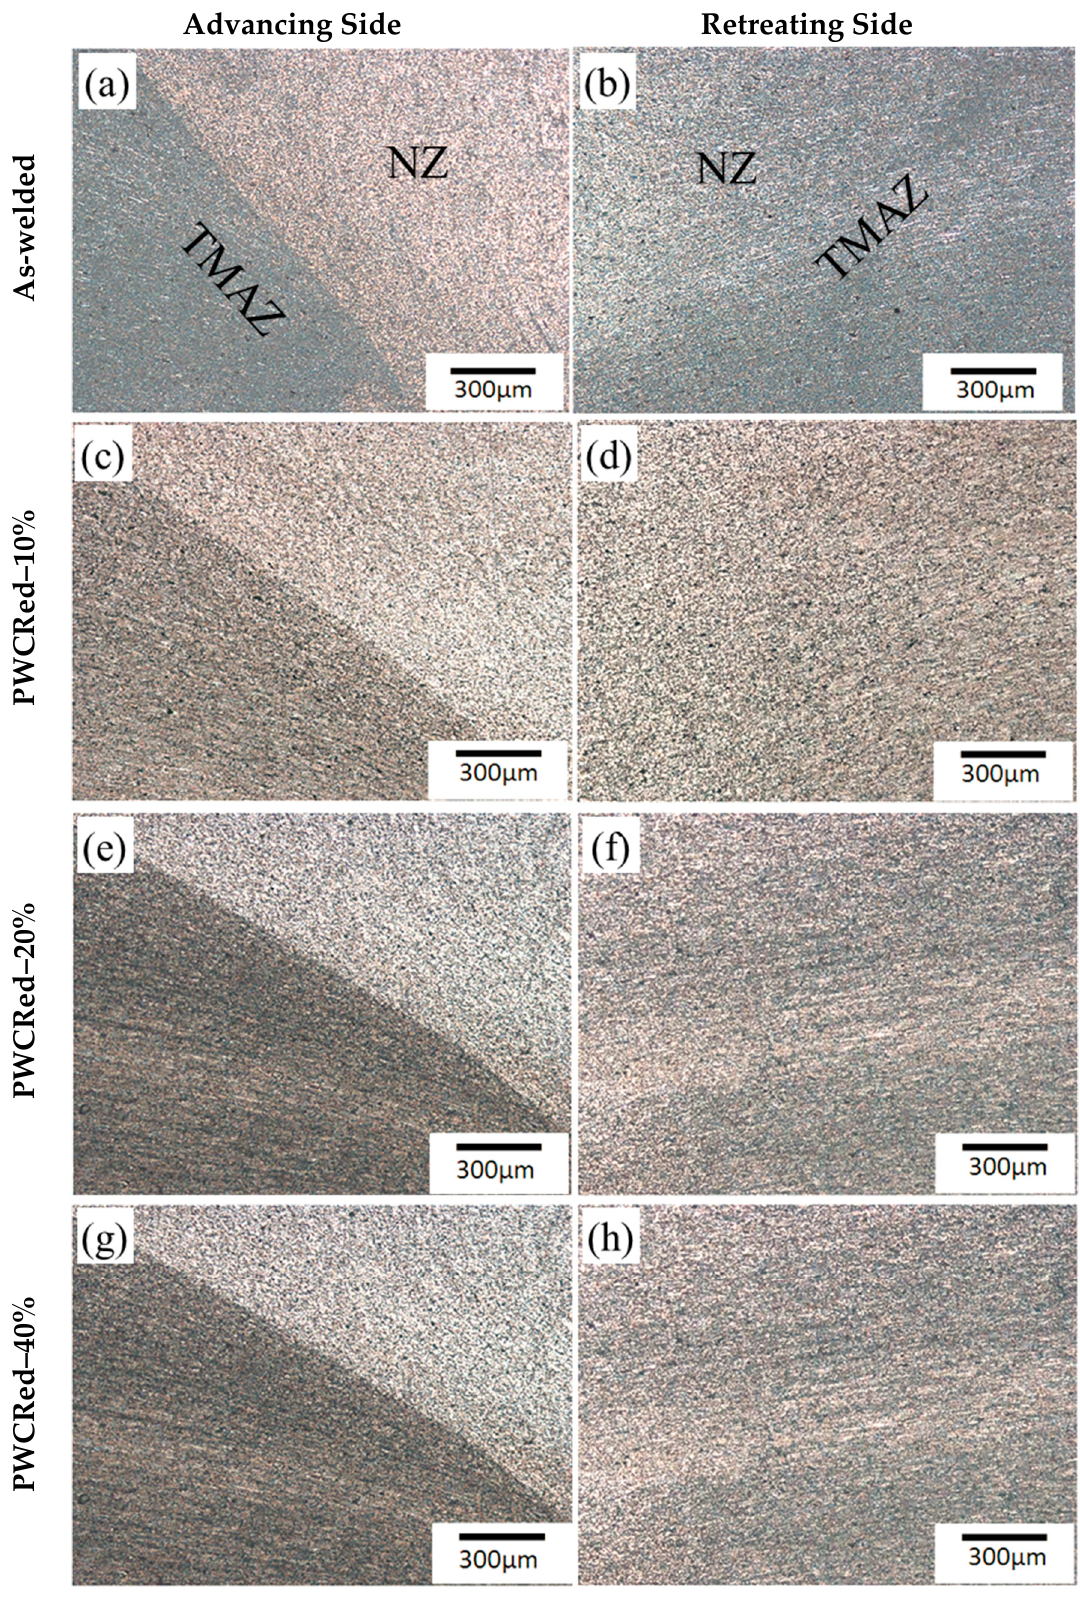
Figure 3. Microstructures of the as-welded and post-weld cold-rolled samples. TMAZ, thermomechanically a ff ected zone; NZ, nugget